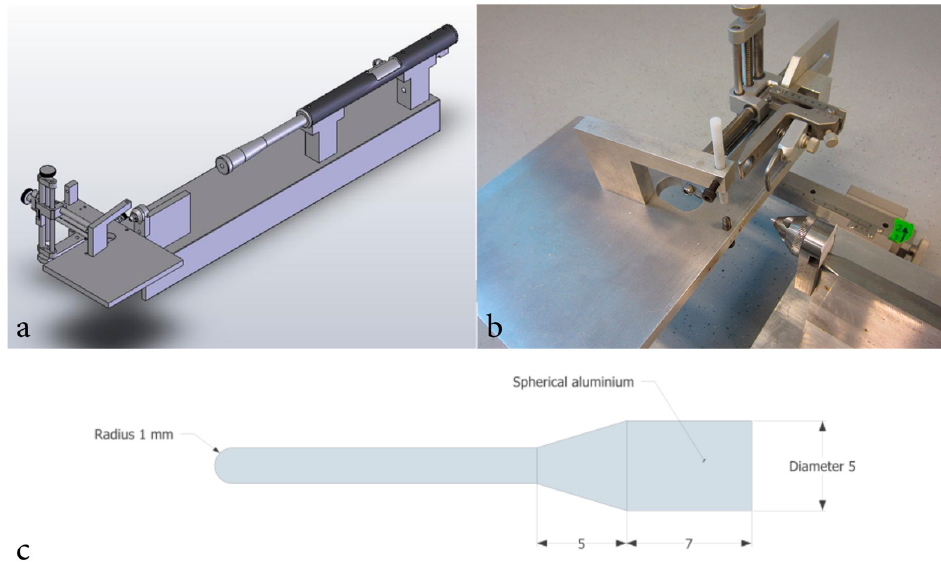
Figure 7. Schematic illustration of the equipment used for inducing penetrating traumatic brain injury. Schematic illustration of the trauma model ( a ), image of the stereotactic frame, animal platform and cone formed probe guider ( b ). Schematic illustration of secondary impactor probe design ( c ).